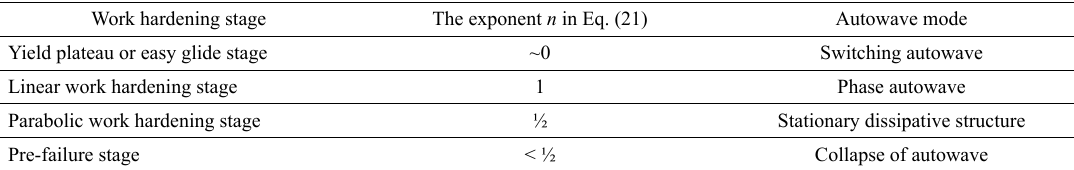
Table 2. Plastic flow stages matched against autowave modes.